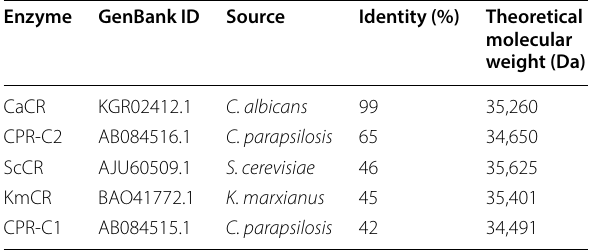
Table 3 Selected proteins from GenBank by BLAST against CaAKR Enzyme GenBank